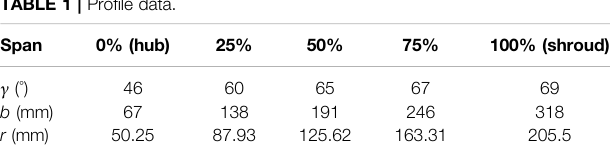
TABLE 1 | Pro fi le